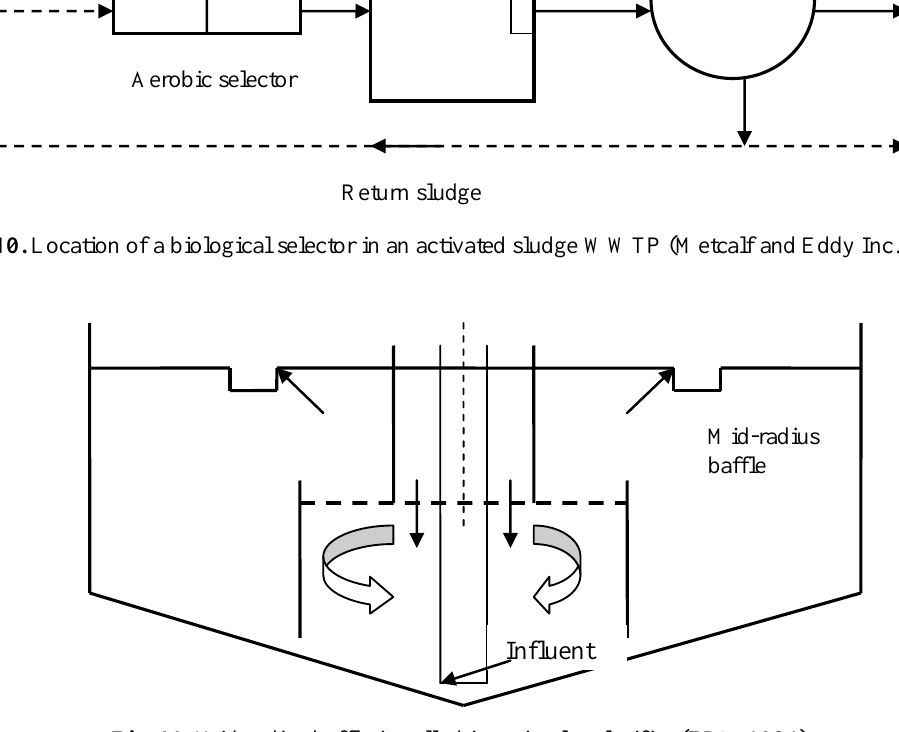
Fig. 11. Mid-radius baffle installed in a circular clarifier (EPA,